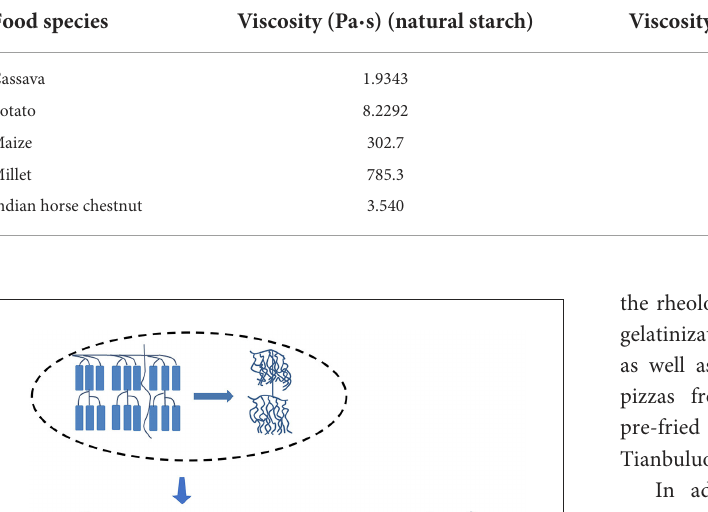
TABLE 2 Effect of microwave treatment on starch viscosity in food.